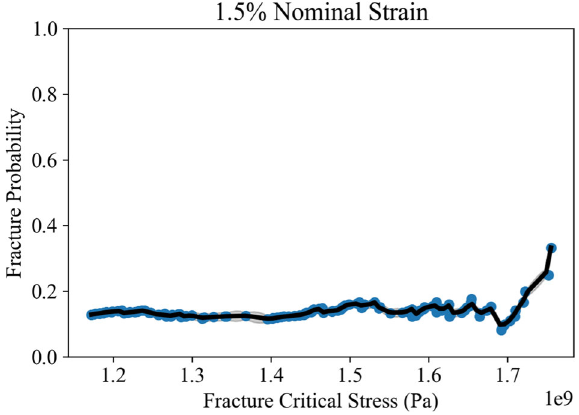
Fig. 8 Fitted GPR representing the failure probability for fracture critical stress levels at 1.5% nominal strain.